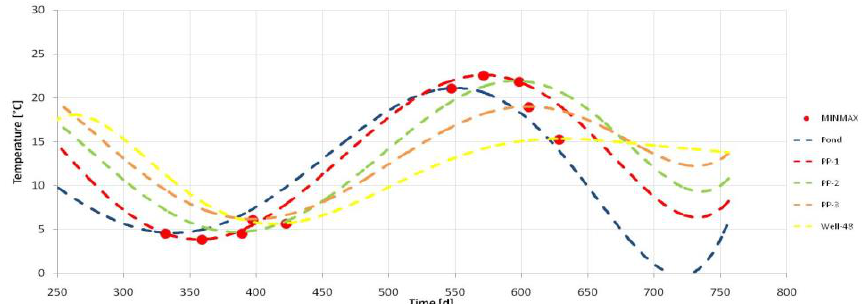
Figure 2. Temperature changes in the sampling points during the research period from October 2018 to March 2020. Table 2. The distance of measuring points from the bank of the pond and retention time. Sampling Points (Figure 1)